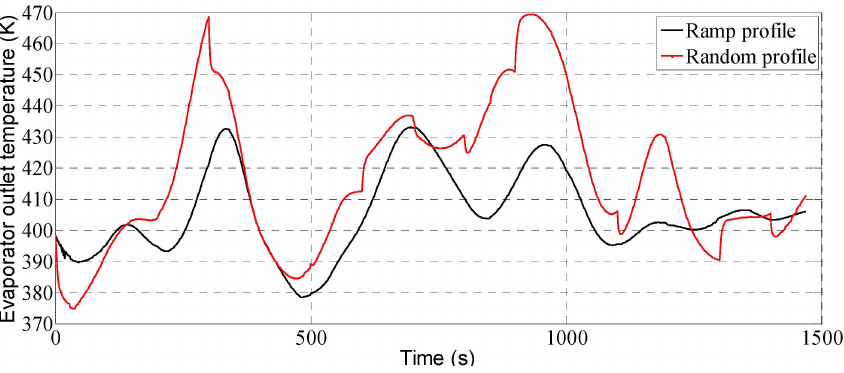
Figure 11. Evaporator outlet temperature of the FV